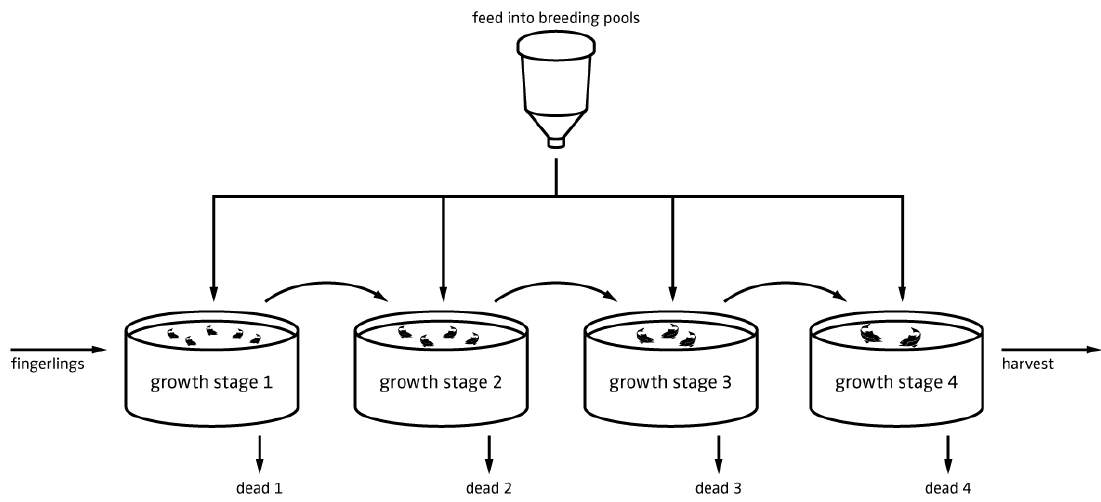
Figure 7. Fluctuation of the water composition is closely linked with the system’s nutrient input. As the main input in aquaponic systems is fish feed, aquaponic systems should be running with fish of several growth stages to ensure a close to constant uniform feed input to the system. The amount of fish does not change drastically; different fish sizes were used for illustration purposes only.